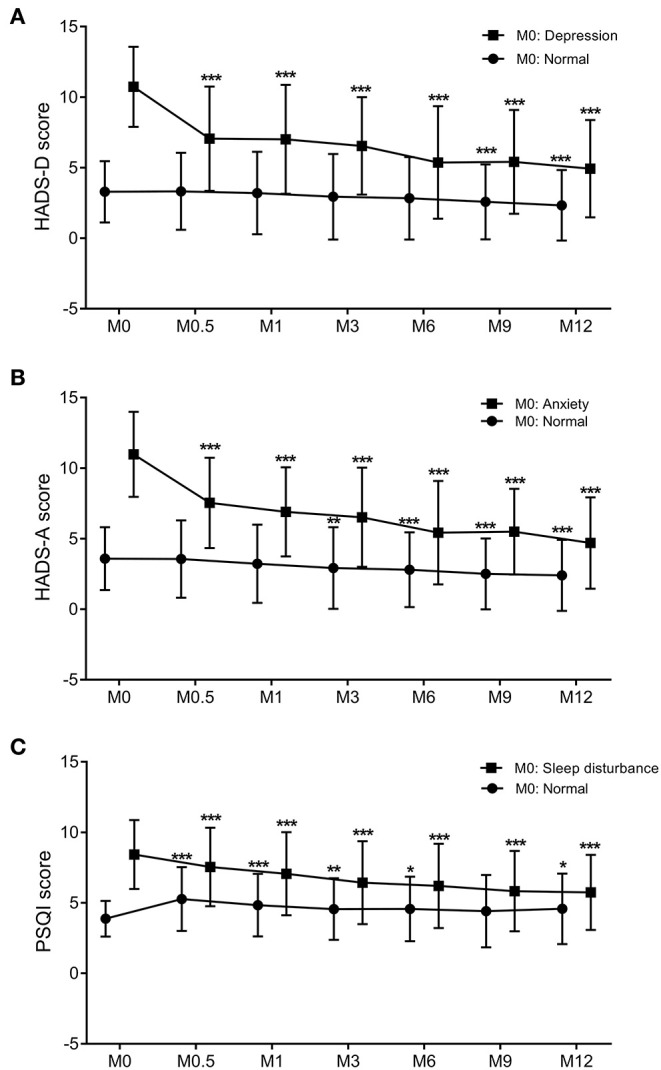
The trend of changes in the PSQI (A), HADS-D (B), and HADS-A (C) scores over the 12-months follow-up period. Graphs show the mean values and SDs at each trimester. Comparison between two groups was performed by paired t-tests. p < 0.05 was considered statistically significant. *: 0.01 < p < 0.05 compared to M0; **: 0.001 < p < 0.01 compared to M0; ***p < 0.001 compared to M0. PSQI, Pittsburgh Sleep Quality Index; HADS-D, Hospital Anxiety and Depression Scale-Depression subscale; HADS-A, Hospital Anxiety and Depression Scale-Anxiety subscale; M, month. Dots: individuals with normal HADS-A, HADS-D, or PSQI scores at baseline. Squares: individuals with abnormal HADS-A, HADS-D, or PSQI scores at baseline.